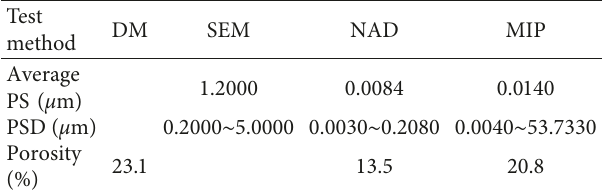
0.1 Figure 12: Variation rate of intruded height. 3# sample is under free restraints. 1# sample is under lateral restraints. Table 5: Comparison of different test methods.